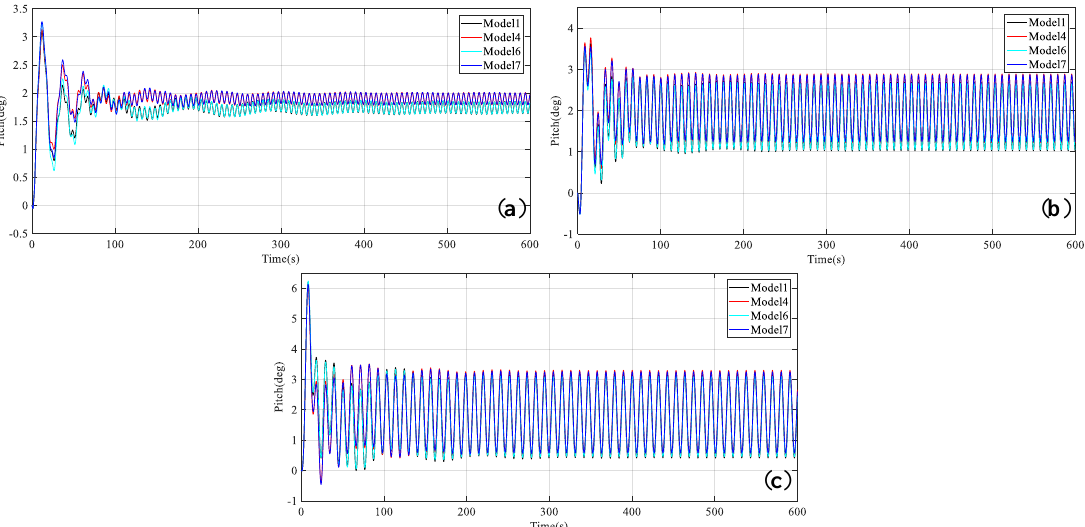
Figure 21. Comparison of the heave motion of Model 1, 4, 6, and 7 in the time domain: ( a ) LC1; ( b ) LC2; and ( c ) LC3.